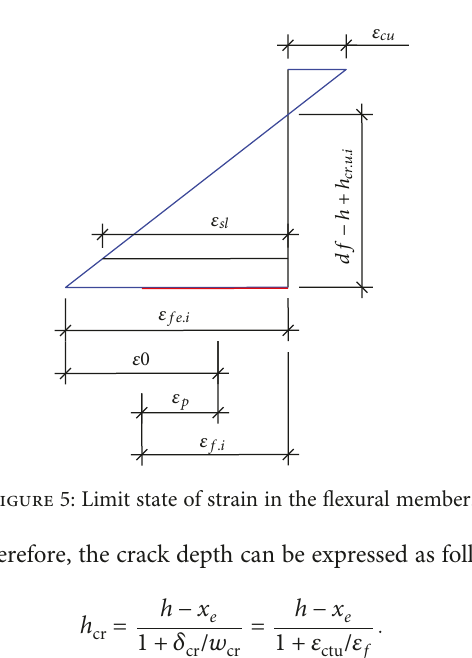
Figure 4: State of stress in RC beam strengthened with (a) EB FRP reinforcement and (b) NSM FRP reinforcement.